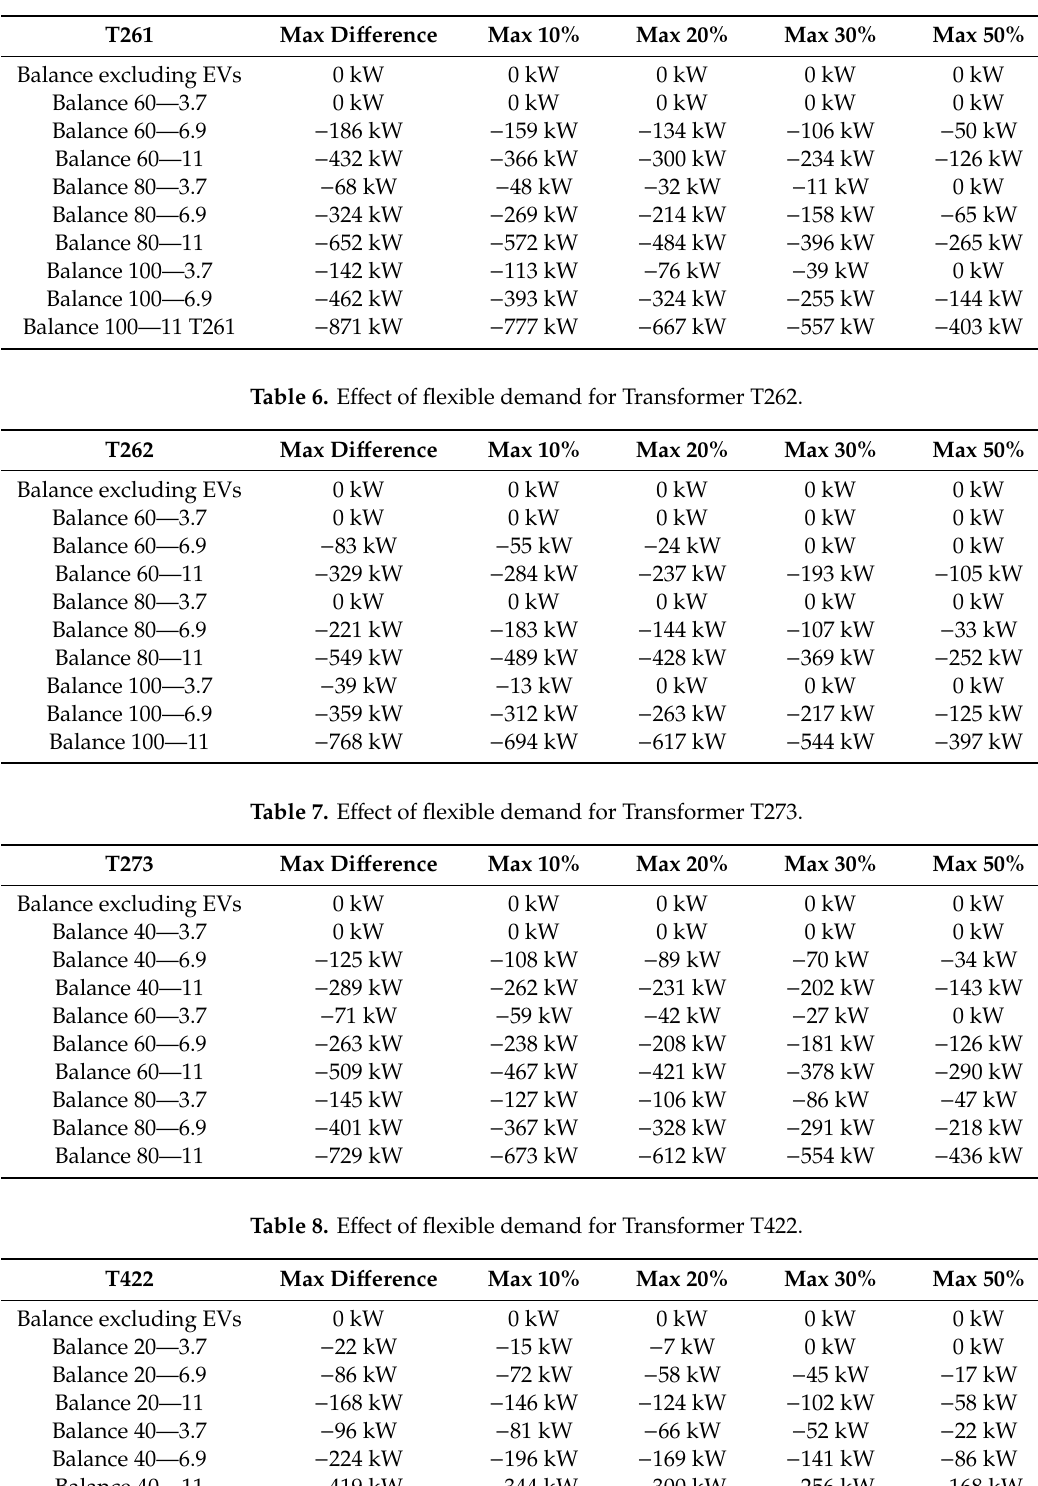
Table 5. E ff ect of flexible demand for Transformer T261.